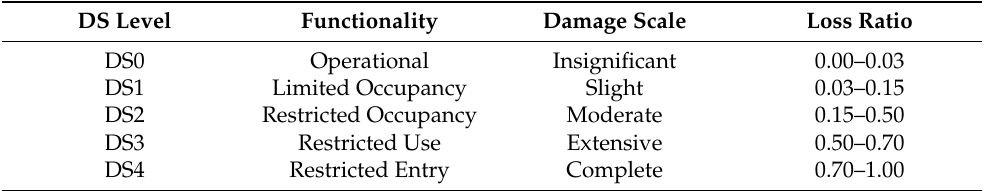
Table 3. Anticipated functionality level associated with each damage state along with their damage scale and loss ratio